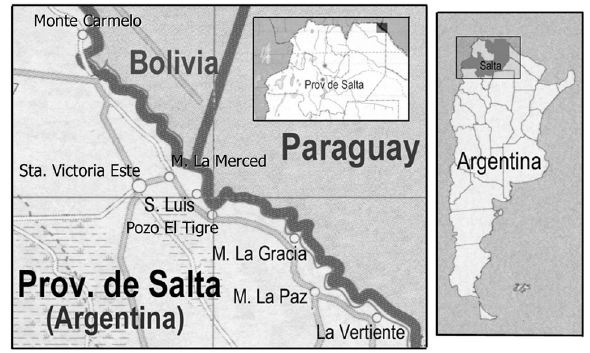
Figure 2 - Geographical location of groups studied. Dejean et al